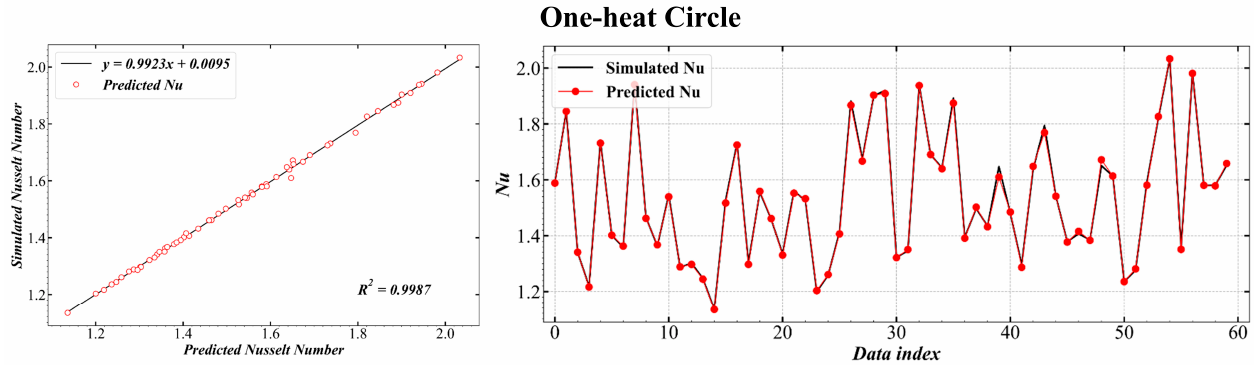
Figure 6. Comparison of predicted and simulated average Nusselt number with various inner cylinder diameters and positions on 60 test data.